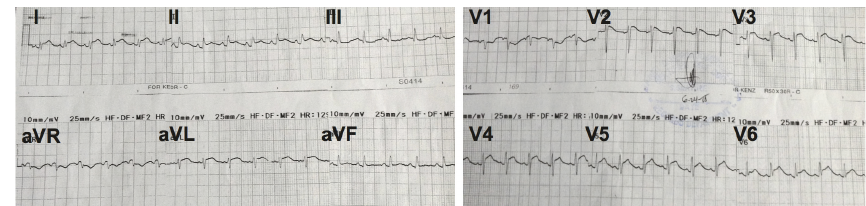
Figure 1: ECG showed diffuse ST elevation and PR segment depression (except in leads aVR and V 1 ), consistent with pericarditis.